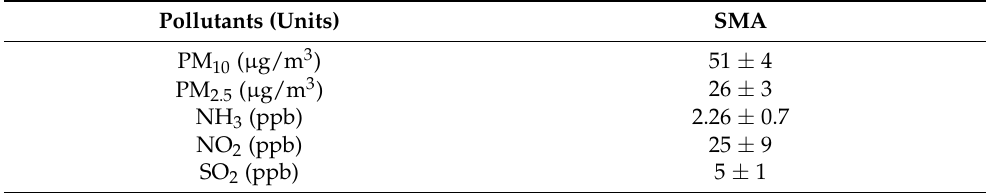
Table 2. Average concentrations of air pollutants including PM 10 , PM 2.5 , NH 3 , NO 2 , and SO 2 in Seoul Metropolitan Area (SMA), South Korea from 2015 to